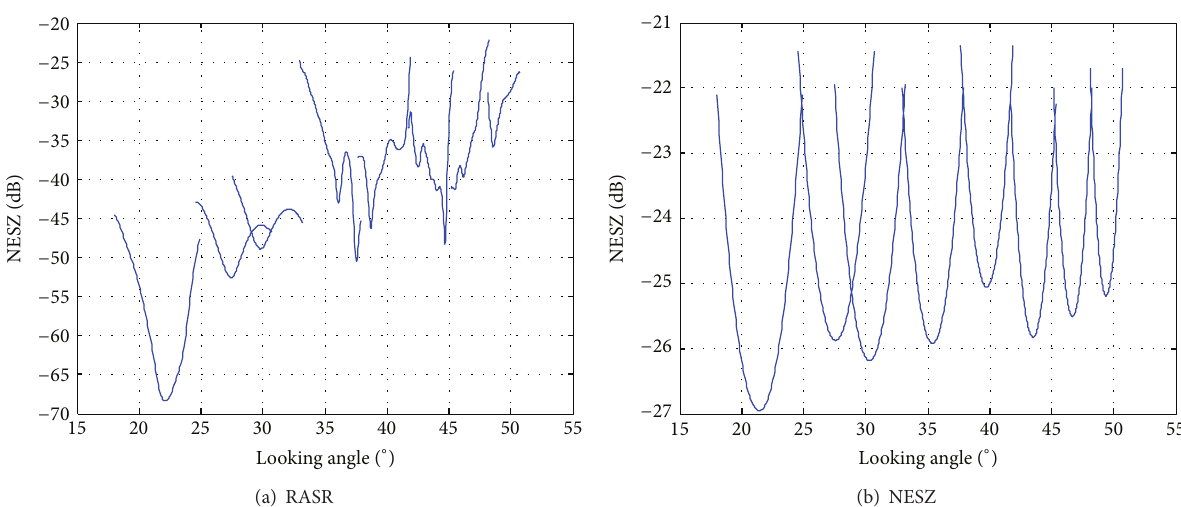
Figure 7: System performances of the designed SAR system with conventional DBF on receive.